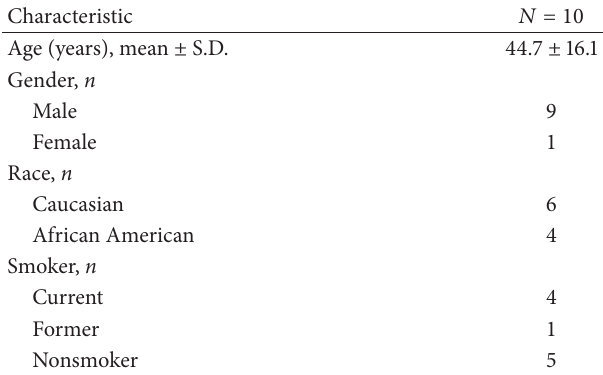
Table 2: Sociodemographic characteristics of patients who under- went spirometry.